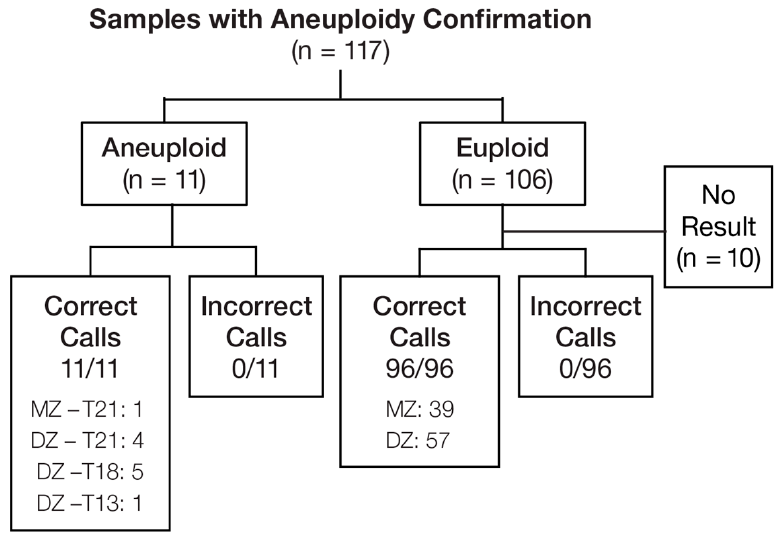
Figure 5. Aneuploidy determination. MZ—monozygotic; DZ—dizygotic.